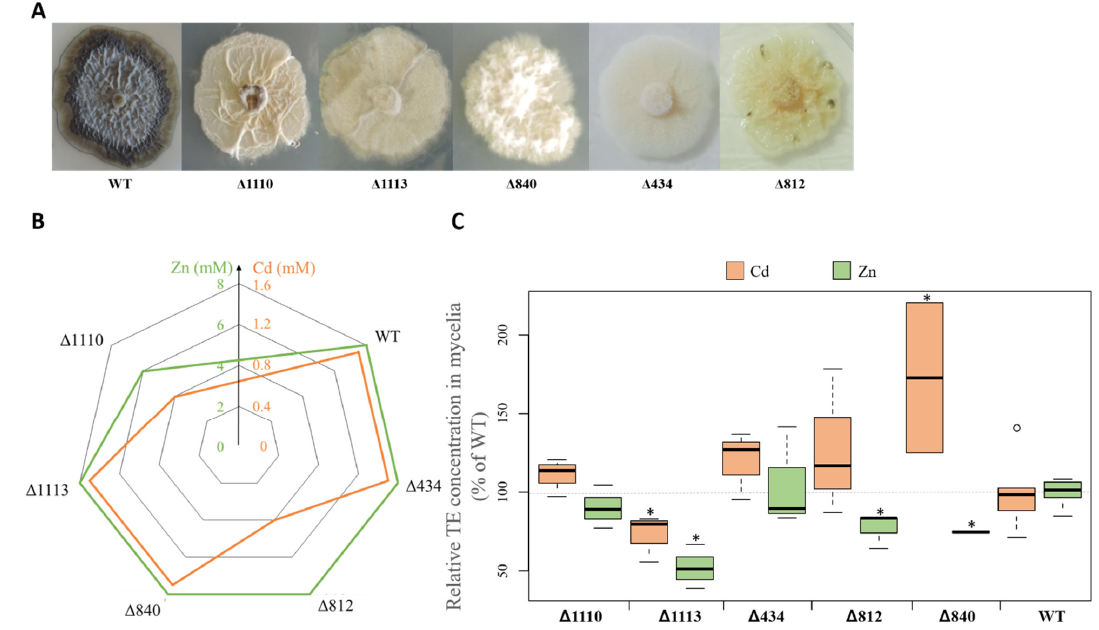
Figure 5. Zn and Cd tolerance and accumulation in the mycelia of Leptodontidium sp. Me07 albino mutants. ( A ) Phenotypes of two-week-old colonies of WT and albino mutants on Pachlewski medium. ( B ) Zn and Cd tolerance of WT and albino strains. Data represent MIC values. MIC is the minimum inhibitory concentration of metal that completely inhibited fungal growth. The experiments were repeated three times with similar results. ( C ) Cd and Zn accumulation in WT and albino mutants. Values are medians ± quartiles ( n = 6). Cultures were incubated for 2 weeks in the presence or absence of 200 µ M Cd or 1 mM Zn. Stars denote significant di ff erences between albino strains and the WT control ( p < 0.05, Kruskal–Wallis